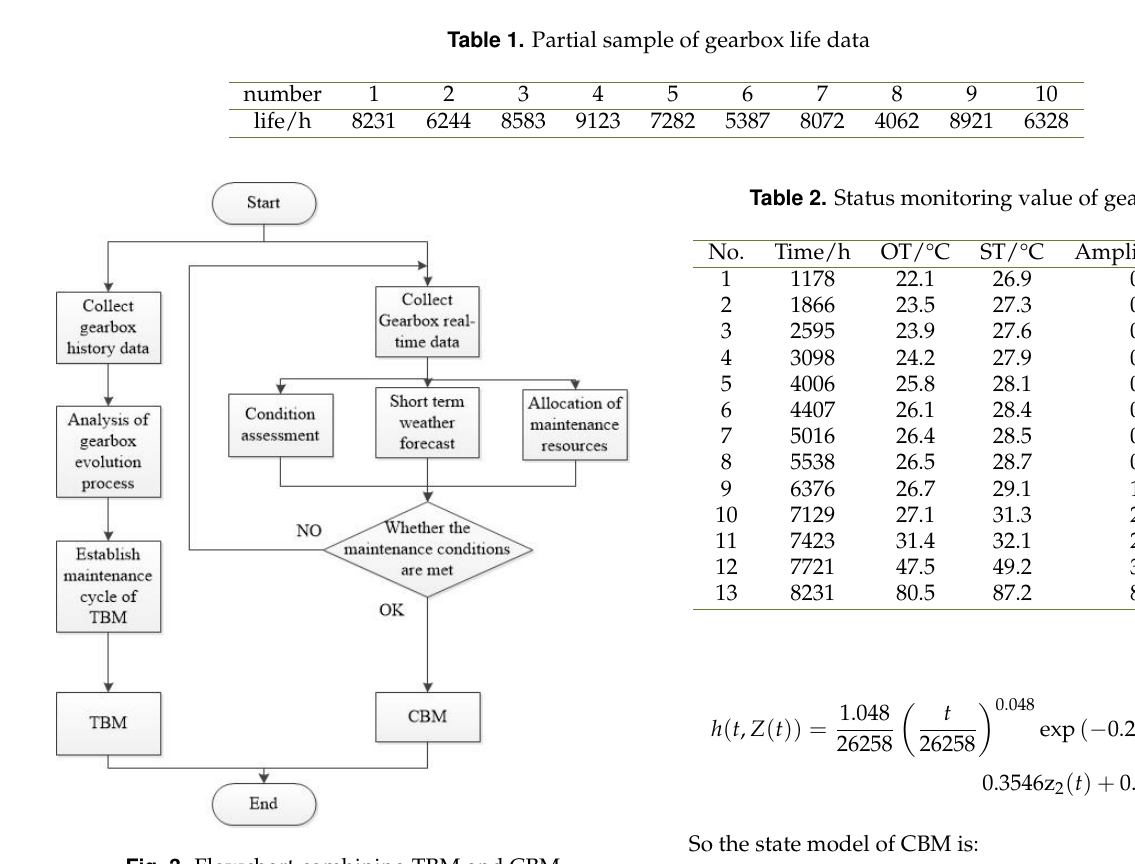
Fig. 3. Flowchart combining TBM and CBM